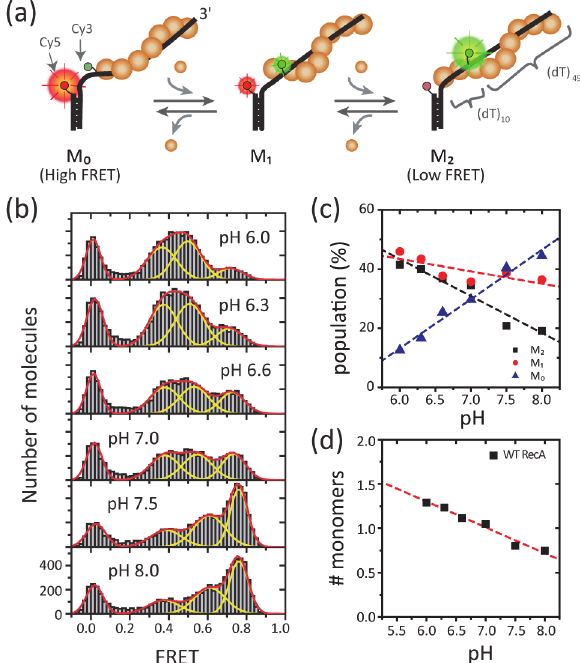
Figure 1. pH dependent stability change of RecA filament at 5 0 -disassembly end. (a) A model for RecA monomer binding and dissociation at the filament end. (b) Single molecule FRET histograms at different pH. The histogram was fit with three Gaussian peaks for M 0 , M 1 , and M 2 states, respectively, with additional peak at 0 for donor-only molecules. (c) The populations for each peak found in (b) at various pHs (symbols). Dashed lines are eye guides. (d) Average number of monomers bound between donor and acceptors (filled rectangles) calculated from (c): N average = 2 * P(M 2 ) + 1 * P(M 1 ) +0 * P(M 0 ), where P(M i ) is the population in M i state. Red dashed line is a linear fit to the data with a slope −